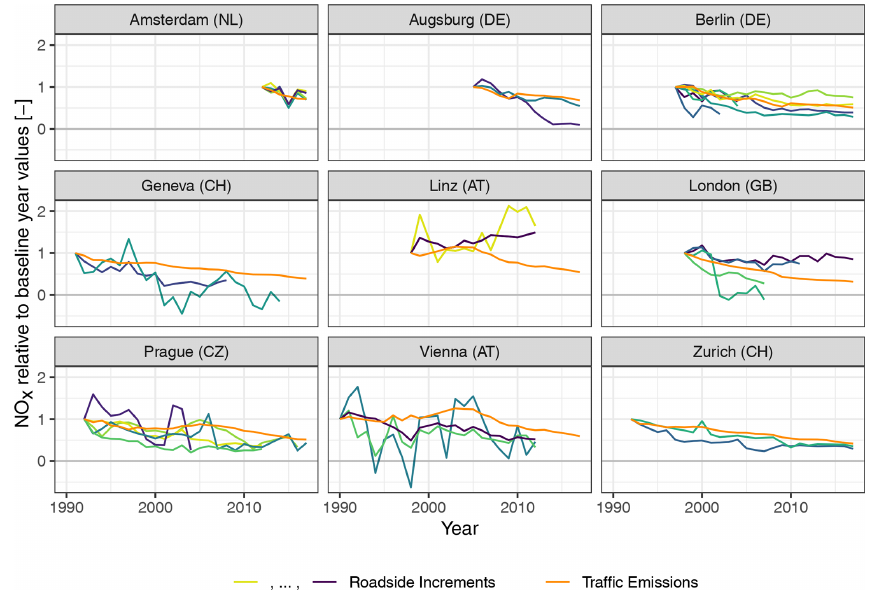
Figure 4. Roadside increments (RIs) and traffic emissions of NO x for nine European cities, relative to their values from a baseline year which was defined individually for each city dependent on the data availability. The traffic emissions (orange lines) are averaged for the urban areas based on the EMEP emissions grid. All other lines depict individual RIs which are specific to a certain urban traffic monitoring